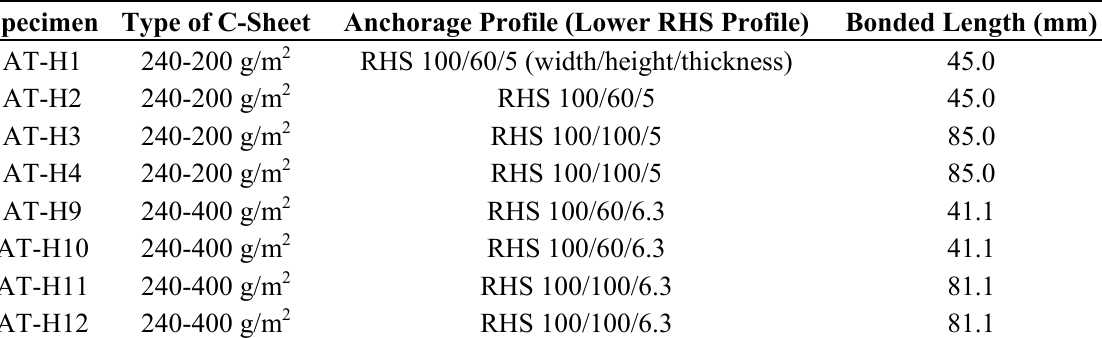
Table 5. Characteristics of Series AT-H.